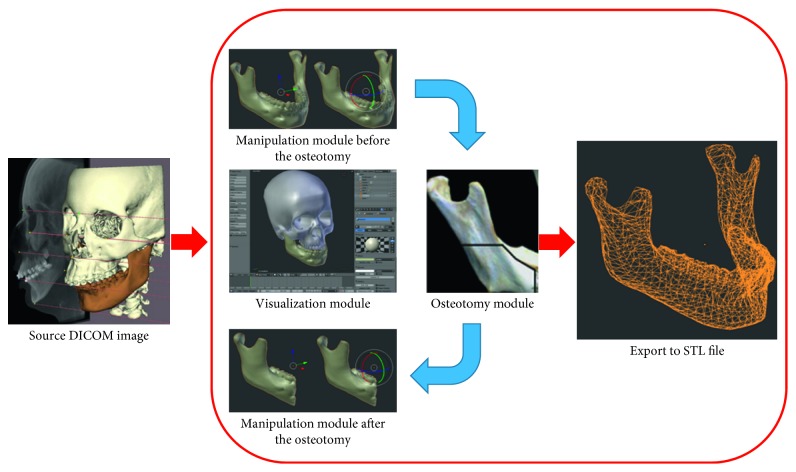
VOSS architecture.